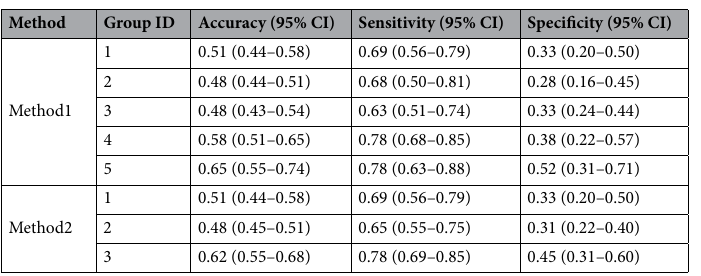
Table 2. Image Turing test results. Accuracy, sensitivity, and specificity of each group and each method.